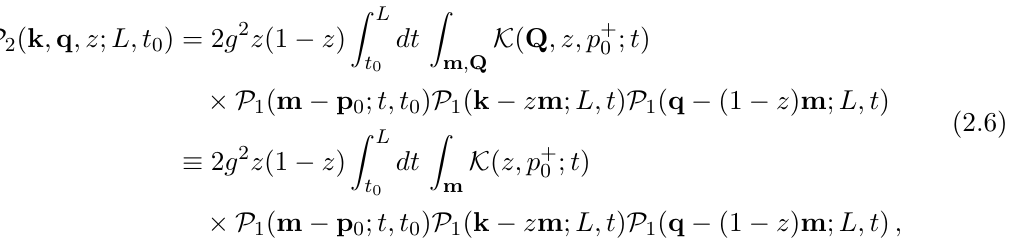
JHEP05(2021)148